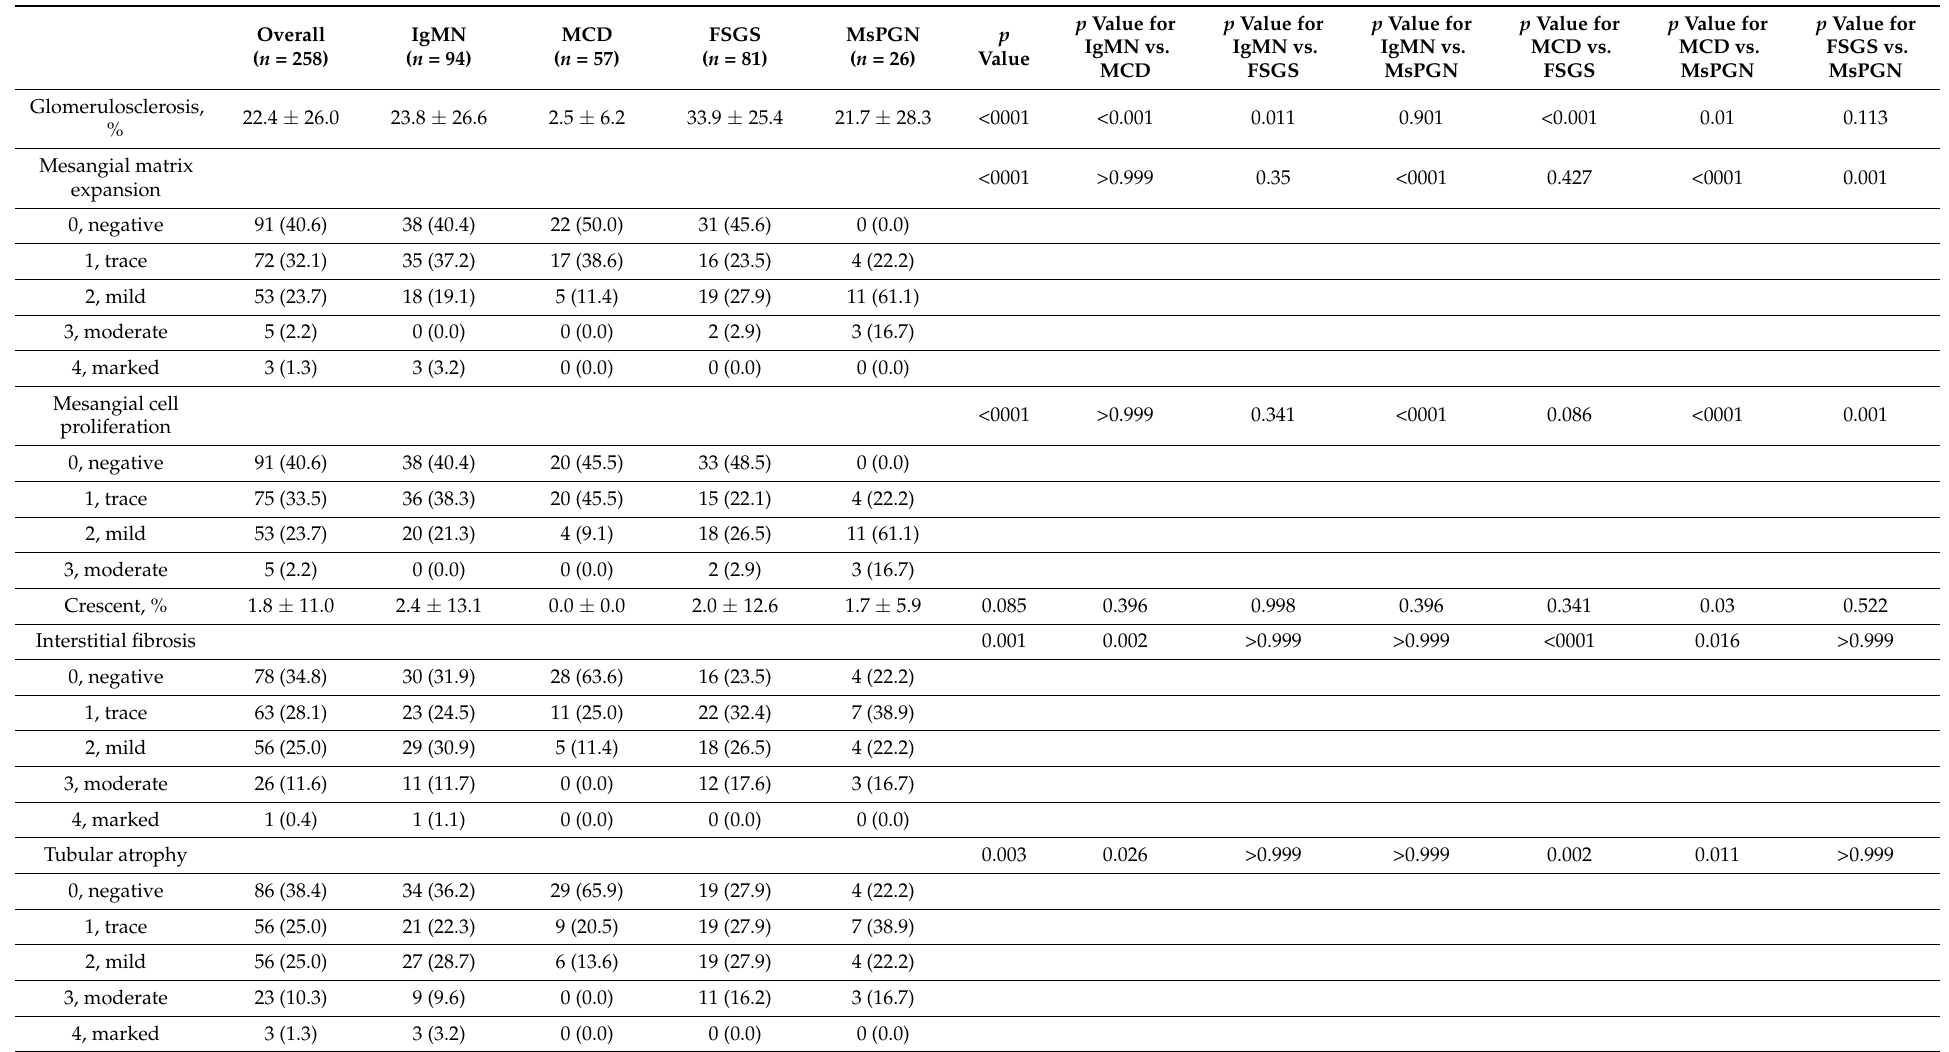
Table 2. Renal pathologic findings of subjects at